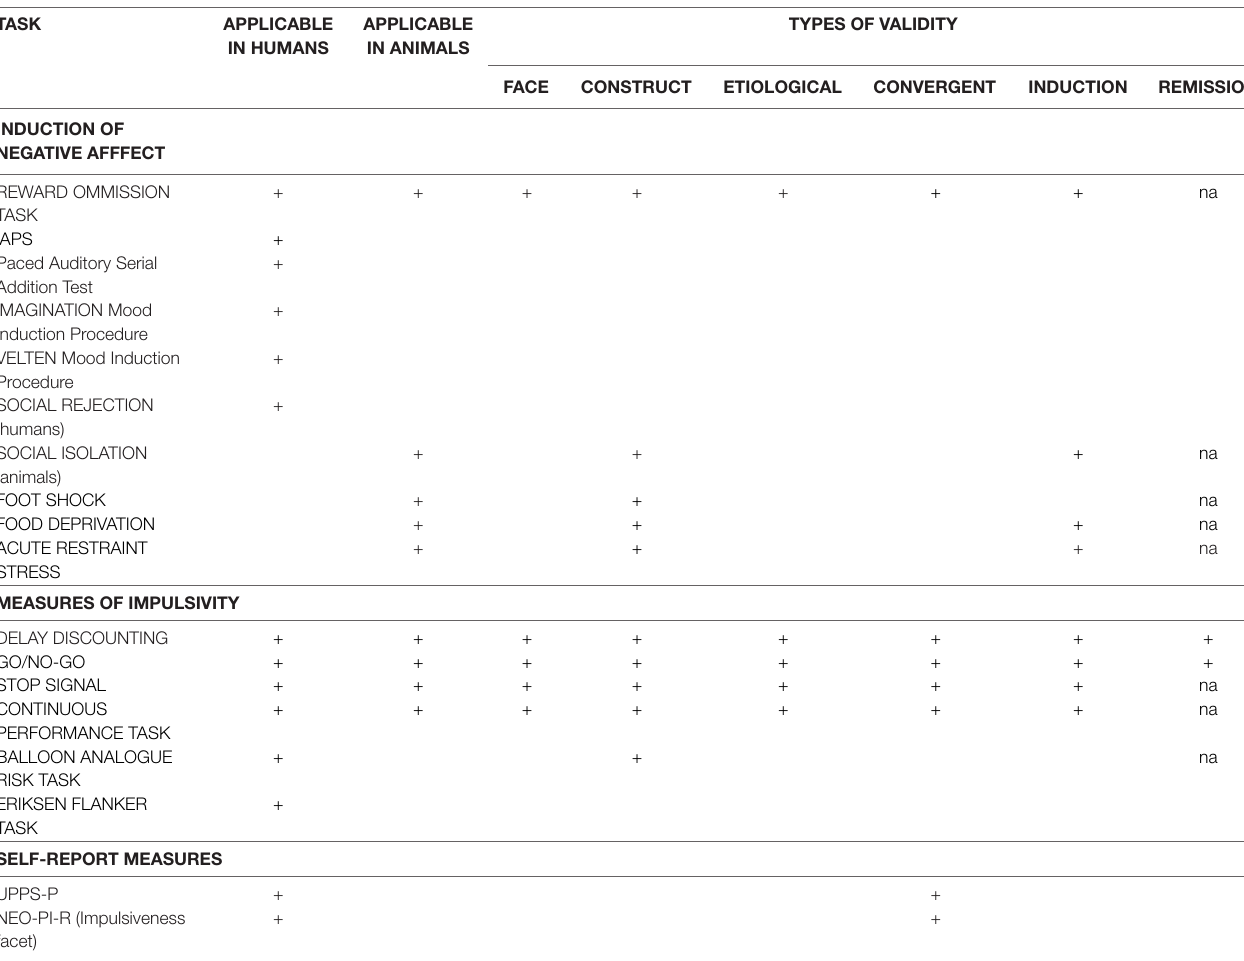
TABLE 1 | Methods for induction of negative affect and measurement of impulsive responding. This table lists several possible suggestions for induction of negative affect in animals and humans and impulsivity assessment. It also outlines which types of validity (which describes translatability) are fulfilled with each task. NEO-PI-R: NEO Personality Inventory, revised; IAPS: International Affective Picture System; na: no available